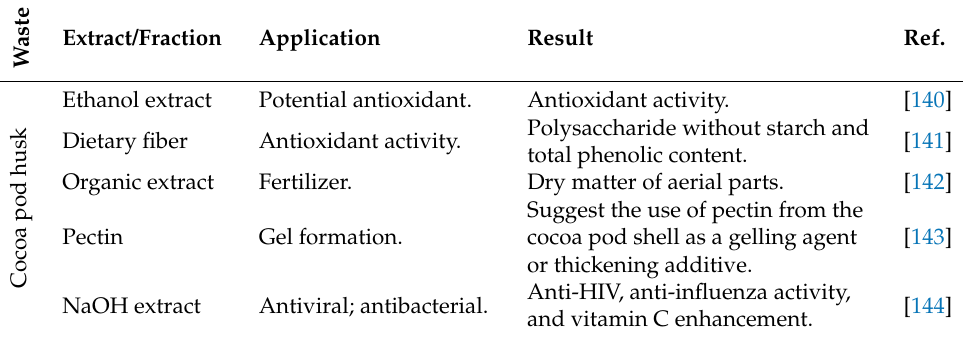
Table 5. Obtaining CPH components by means of chemical